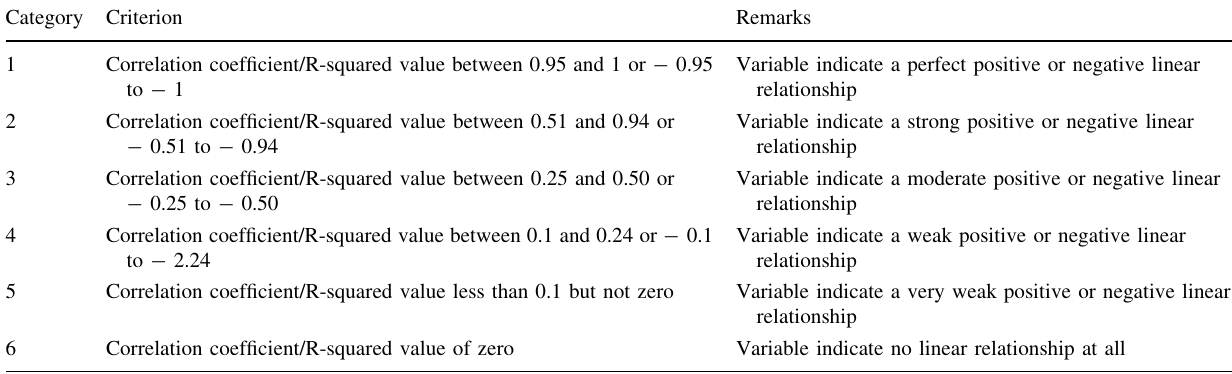
Table 1 Criterion for factors influencing spontaneous combustion liability of coals and coal-shales (Onifade and Genc 2018e) Category Criterion